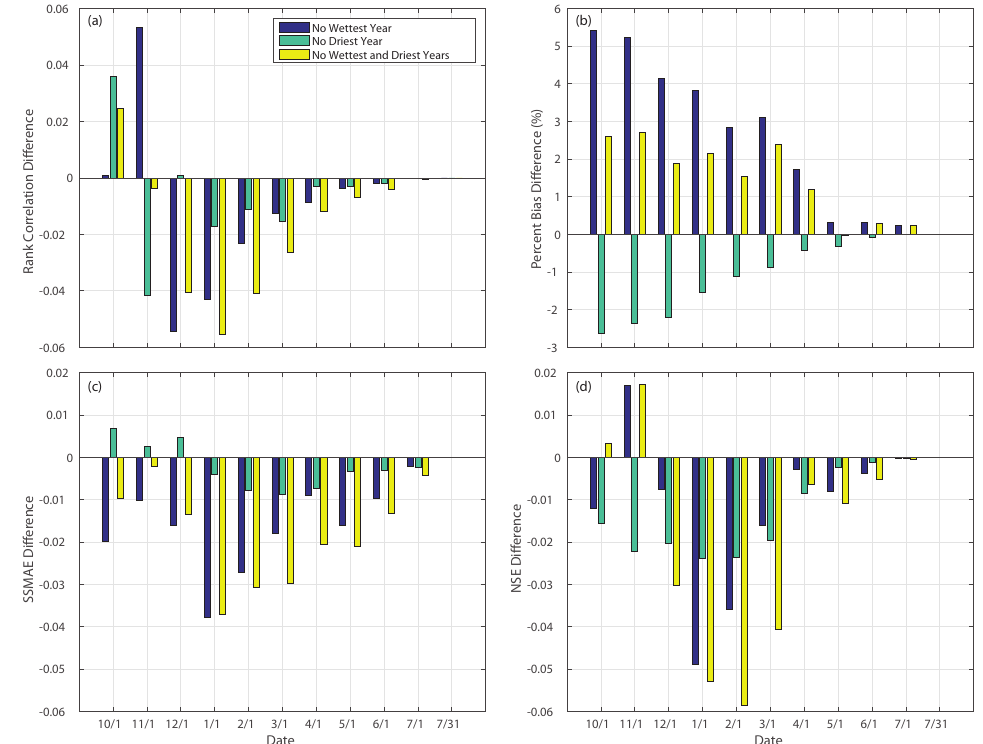
Figure 9. Median differences in the metrics of eight study watersheds: ( a ) rank correlation; ( b ) percent bias; ( c ) mean absolute error skill score and ( d ) Nash–Sutcliffe efficiency between the scenarios with the wettest year, driest year, wettest and driest years unconsidered and the scenario with all years